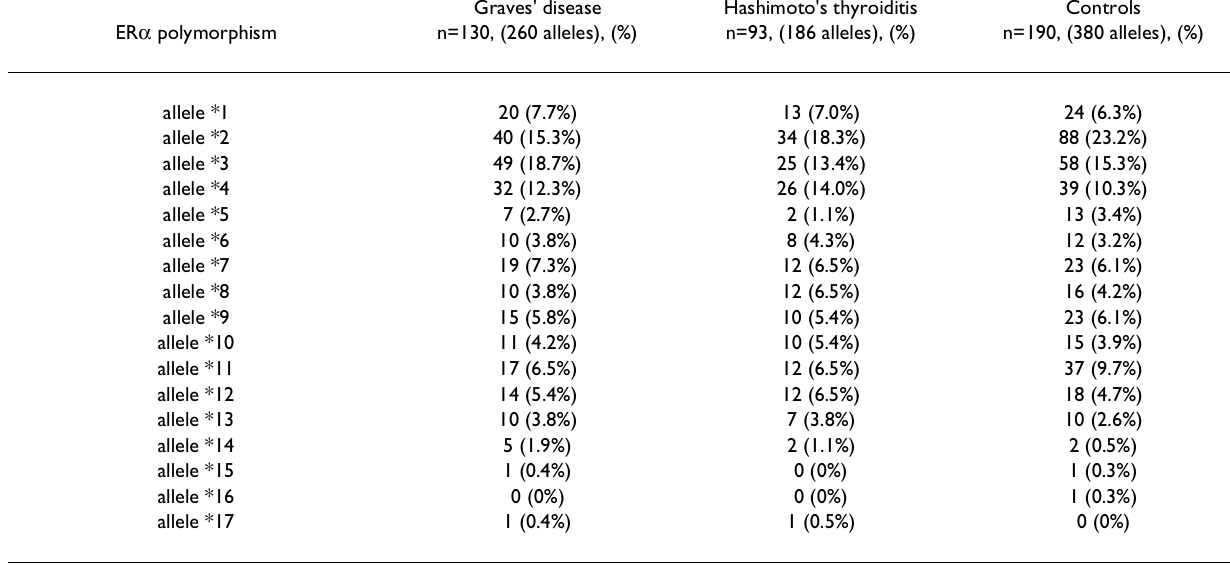
Table 1: Allele frequencies of the ER α gene polymorphism in patients with AITDs and in control subjects Graves'